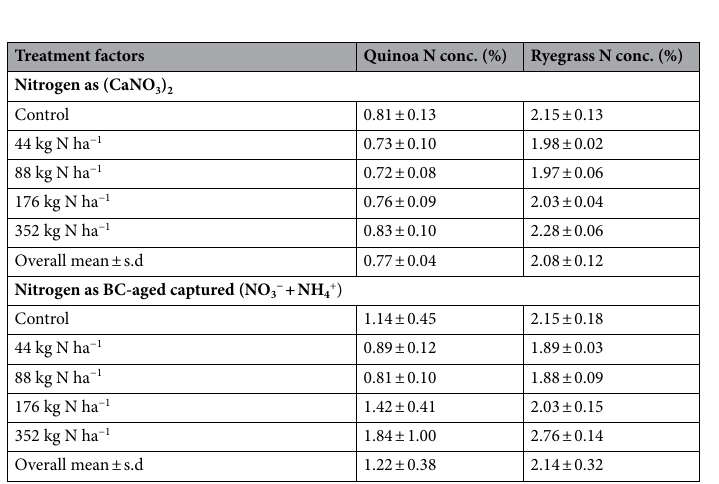
Table 1. Plant (quinoa and ryegrass) tissue nitrogen concentration as influenced by nitrogen sources [(CaNO 3 ) 2 and BC-aged captured (NO 3− + NH 4+ )] at five rates of application (control (no nitrogen), 44, 88, 176 and 352 kg N ha −1 ), n = 4 per treatment. The values are means and standard deviation.